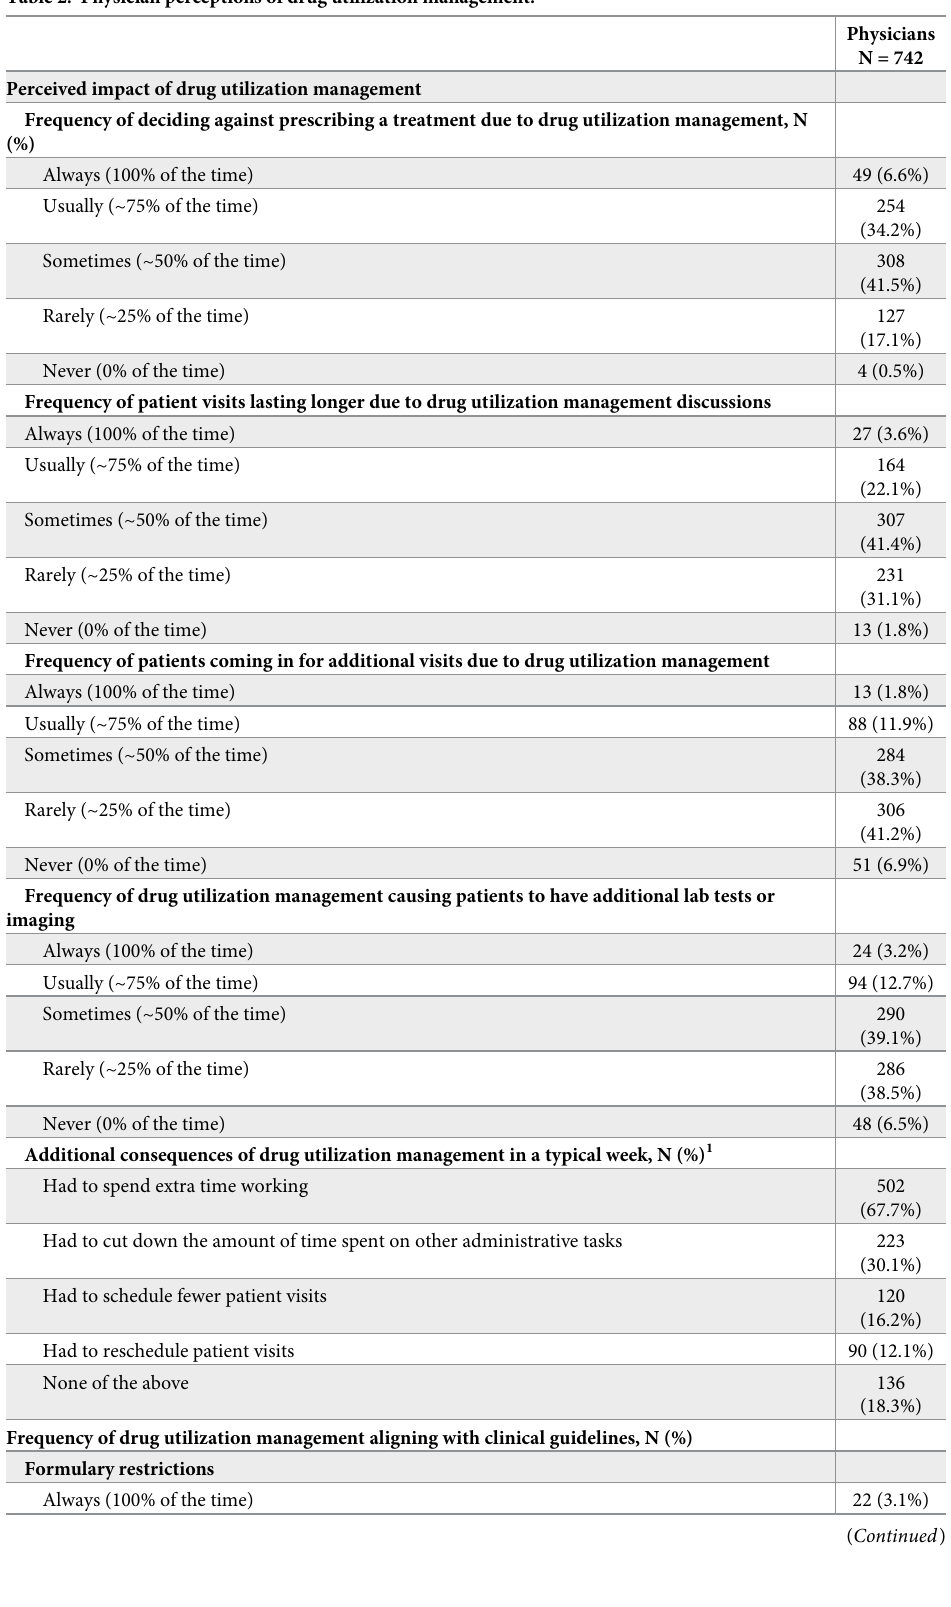
Table 2. Physician perceptions of drug utilization